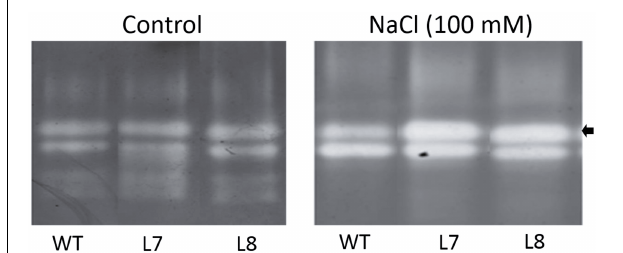
FIGURE 11 | Effect of NaCl on activities of SOD isoenzymes in leaves of wild-type tobacco and KcCSD -transgenic lines. Four-weeks old rooted plants of wild-type (WT) and transgenic lines (L7 and L8) were transferred to 1/4 Hoagland’s nutrient solution for 2-weeks acclimation. Hydroponically acclimated plants were subjected to 0 or 100mM NaCl for 7 days. The arrow indicates remarkably increased SOD isoform in transgenic lines.